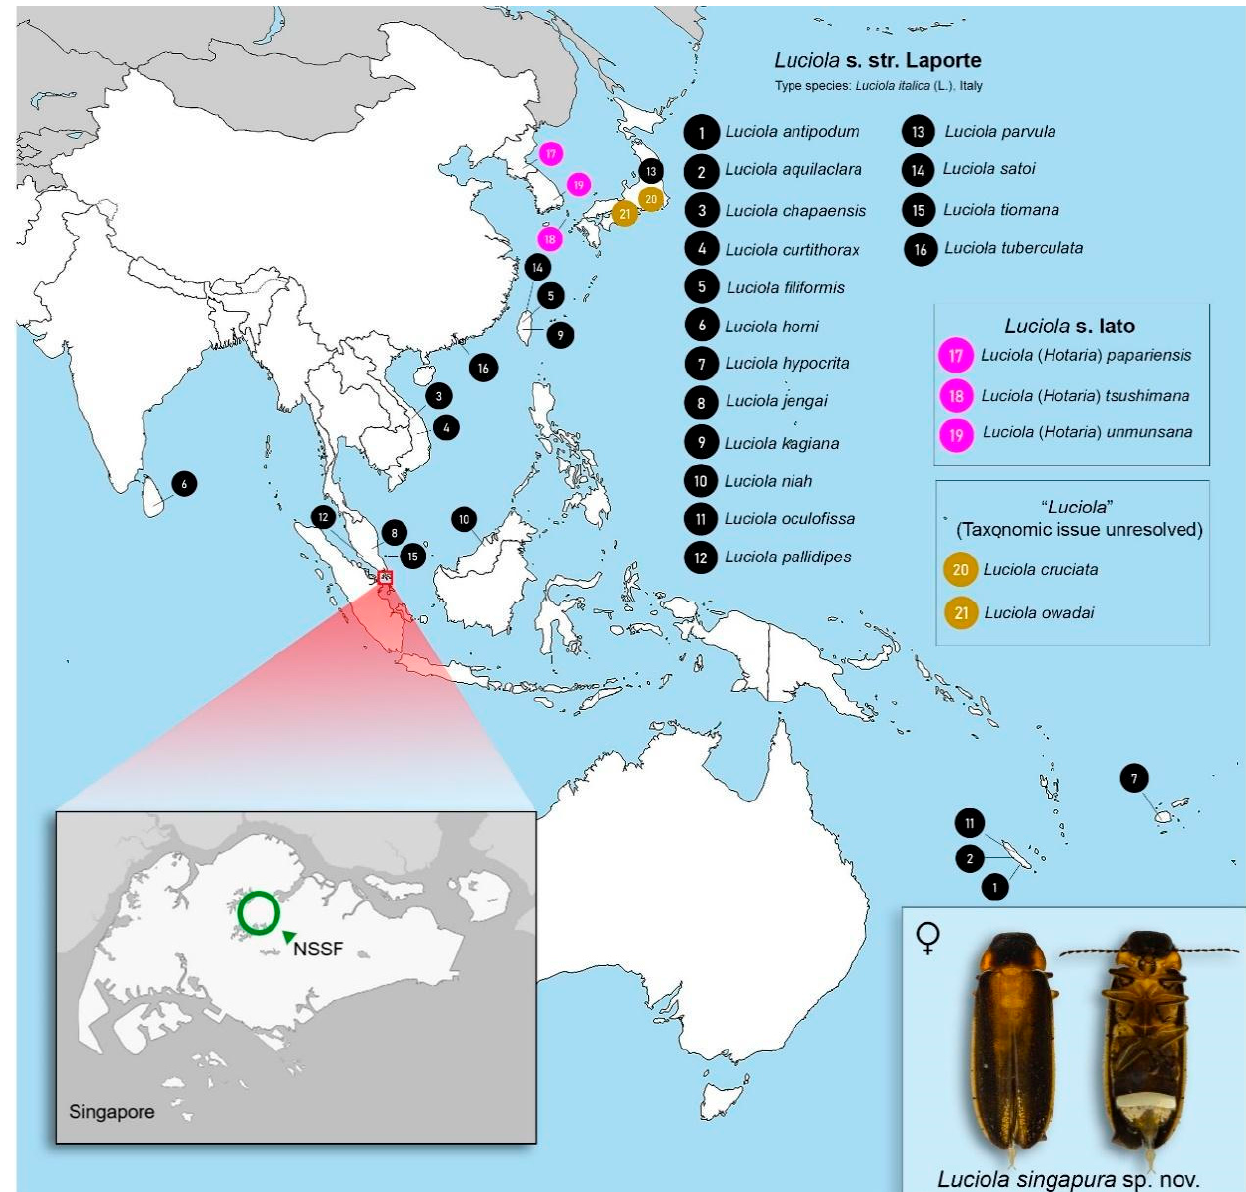
Figure 1. Map of Singapore showing the location of Luciola singapura Jusoh & Ballantyne sp. nov. in the Nee Soon Swamp Forest (NSSF) (inset). Numbered dots represent type localities of Luciola species in Asia and the Pacific islands that were examined and/or analysed in this study. List of species in Table S1.